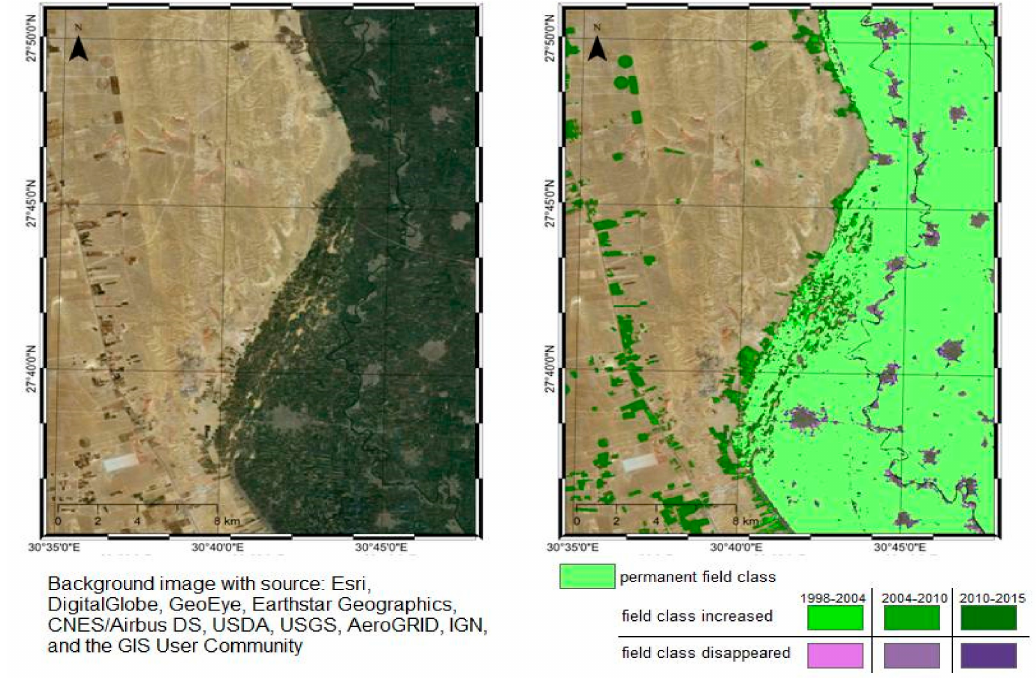
Figure 13. Field classes detected for 1998, 2004, 2010 and 2015 in the Western Dalija region overlaid on a high-resolution optical image (right) and optical image over the area